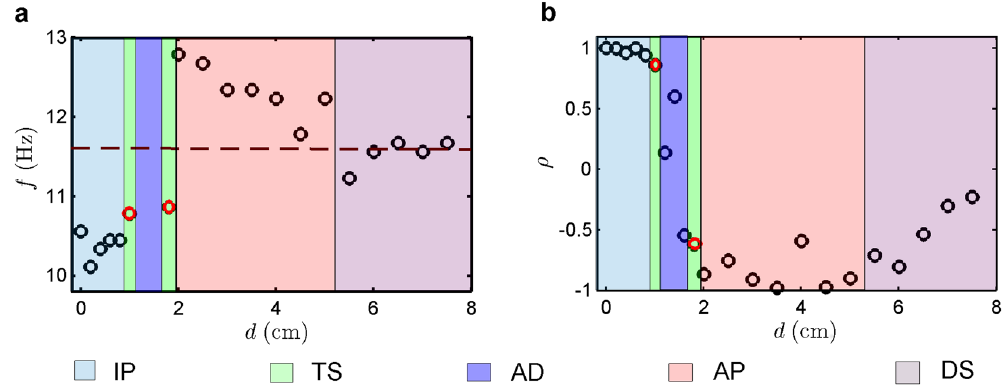
Figure 3. Characterization of synchronization transitions in coupled candle-flame oscillators due to variation in d . The variation of (a) , dominant frequency ( f ) and (b) , Pearson’s correlation coefficient ( ρ ) as a function of d for a pair of candle-flame oscillators. The horizontal dotted line in ( a) corresponds to the dominant frequency of 11.6 Hz obtained from the individual oscillator in an uncoupled state. IP oscillations can be characterized by the drop in the frequency value as well as ρ tending to positive unity. In contrast, AP oscillations are characterized by an increase in the frequency value when compared to the uncoupled oscillator as well as ρ tending to negative unity. The transition from IP to AP in the frequency plot (in a ) is interposed by the region of AD state. The red circles correspond to the transition states (TS) where the frequency peak in the amplitude spectra represents the oscillatory regions observed in the signals of these states. As the oscillators move to desynchrony, the frequency fluctuates around the frequency of uncoupled oscillators along with ρ moving towards 0, highlighting the reduction in interaction between the oscillators. The amplitude variation of the signals from both oscillators, obtained in terms of root mean square value, as a function of d is provided in Supplementary Fig.